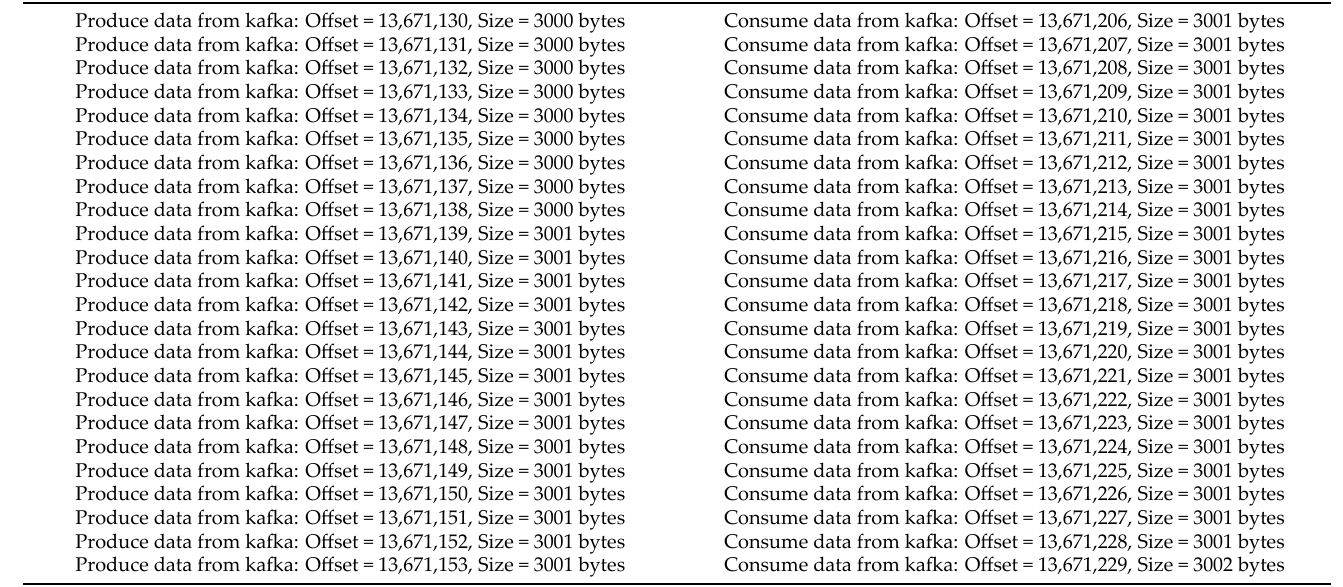
Table 13. Test results for actual data log from lines 13,671,130 to